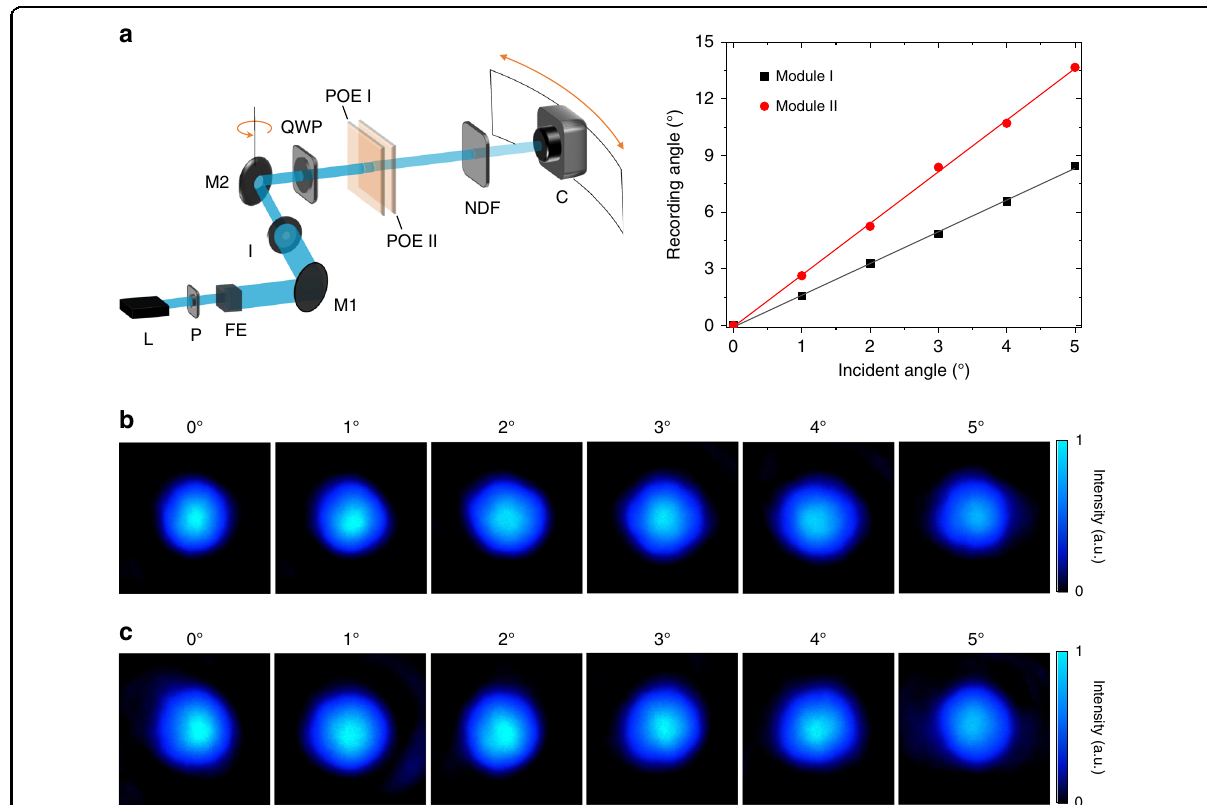
Fig. 4 Angle-magni fi ed beam shape characterization. a Left: Schematic of the measurement setup. A 488-nm circularly polarized laser beam is incident on the planar telescope composed of two POEs. A mirror (M2) is fi xed on a rotational stage for controlling the incident angle. A camera coupled with a neutral density fi lter is applied to record the output laser beam spots and the location of the camera shifts according to the rotation angle of M2. Right: The recording angle of the camera as a function of the incident angle. L laser, P polarizer, FE fi ltering and expansion, M1 mirror I, I iris, M2 mirror II, QWP quarter-wave plate, NDF neutral density fi lter, C camera. b The recorded beam shape of module I as a function of incident angles. c The recorded beam shape of module II as a function of incident